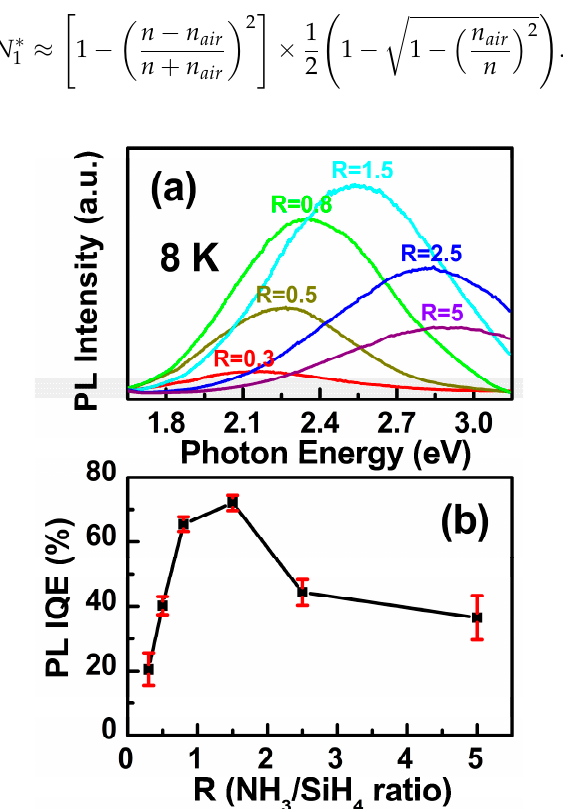
Figure 2. ( a ) The PL properties of a-SiN x O y samples for various R at 8 K. ( b ) The related PL IQEs of a-SiN x O y samples vs. R at RT. a-SiN x O y samples vs. R at